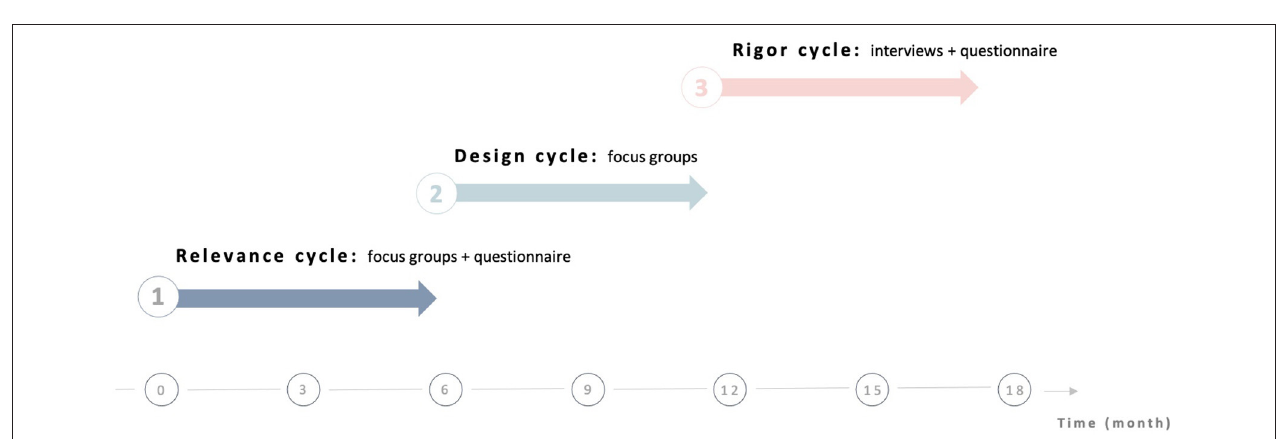
FIGURE 2 | Schematic overview of the ESPOIR 2 S